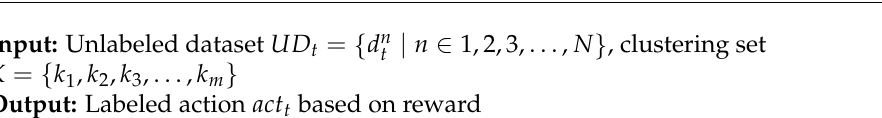
Algorithm 1 DRL-based auto-labeling